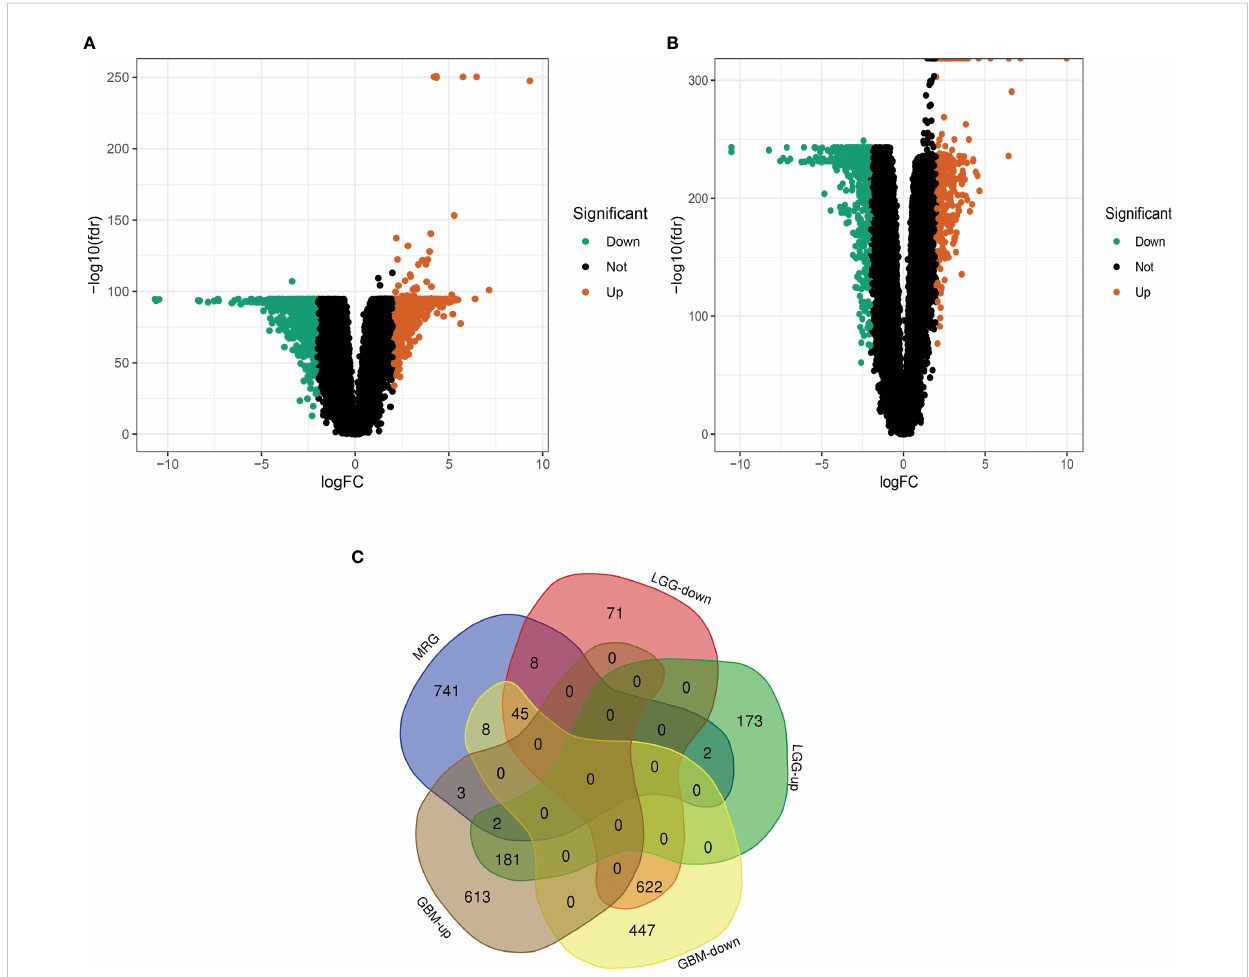
FIGURE 1 Differential analysis of glioma mitochondria-related genes. (A) Volcano map of differentially expressed genes in glioblastoma. Figure (B) Volcano map of differentially expressed genes in low-grade gliomas. Figure (C) Venn diagram of mitochondria-associated differentially expressed genes in glioblastoma and low-grade